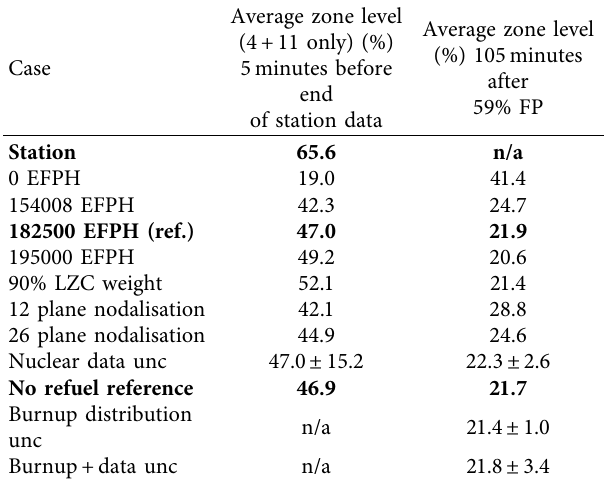
Table 2: Comparison of station data and simulations on zone level fgures of merit. Uncertainties are stated as one standard deviation.